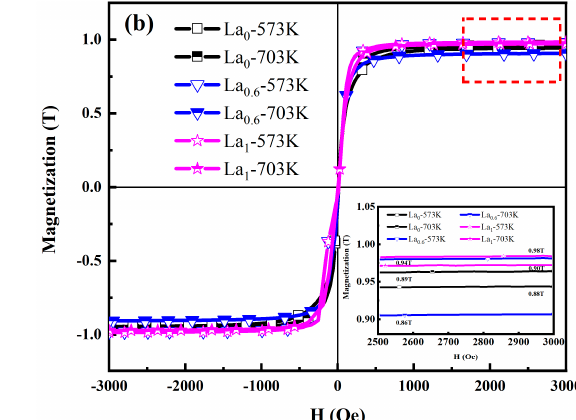
Figure 4. The M – H curves of Fe 27 Co 27 Ni 27 Si 10 − x B 9 La x ( x = 0, 0.6, 1) alloys annealed above the crystal ‐ lization temperature.